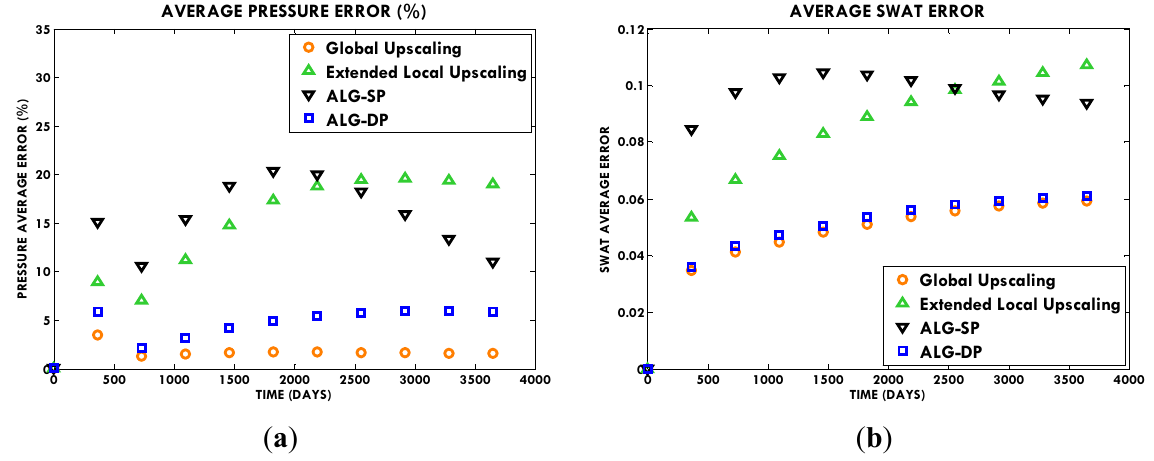
Figure 14. Average field error comparison for case 2: ( a ) pressure error; ( b ) water saturation (SWAT)